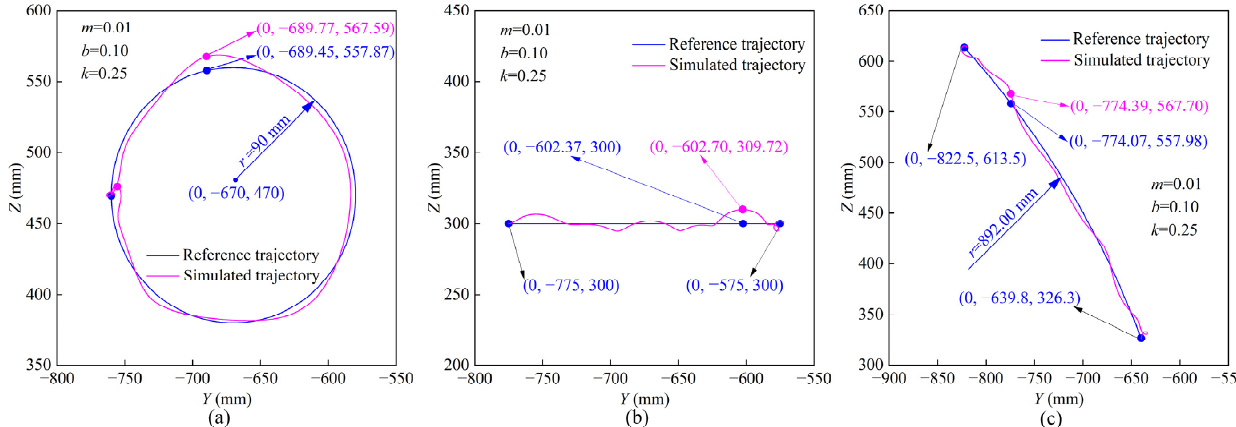
Figure 7. Reference trajectories and simulated trajectories under different training modes: ( a ) MO- TOmed training; ( b ) CPM training; ( c ) SLR training; ( m : N·s 2 /mm; b : N·s/mm; k : N/mm). TOmed training; ( b ) CPM training; ( c ) SLR training; ( m : N · s 2 /mm; b : N · s/mm; k :